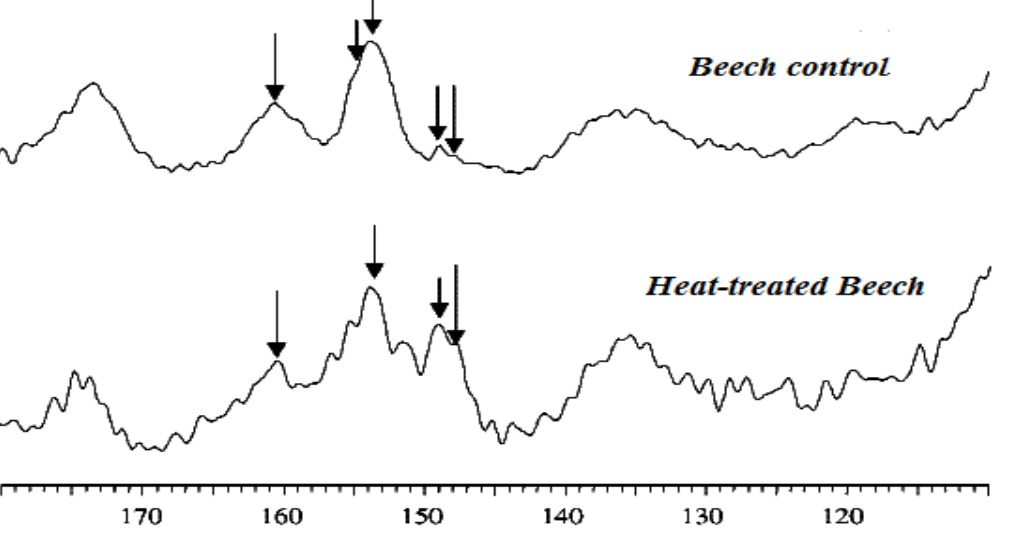
Figure 15. CP MAS 13 C NMR spectra of untreated beech wood and beech wood heat-treated at 230 °C in the 110–180 ppm.